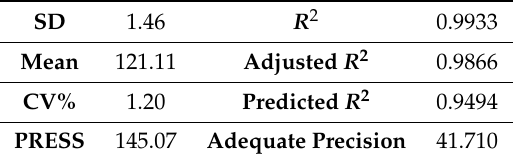
Table 3. Regression coe ffi cient results for the final reduced